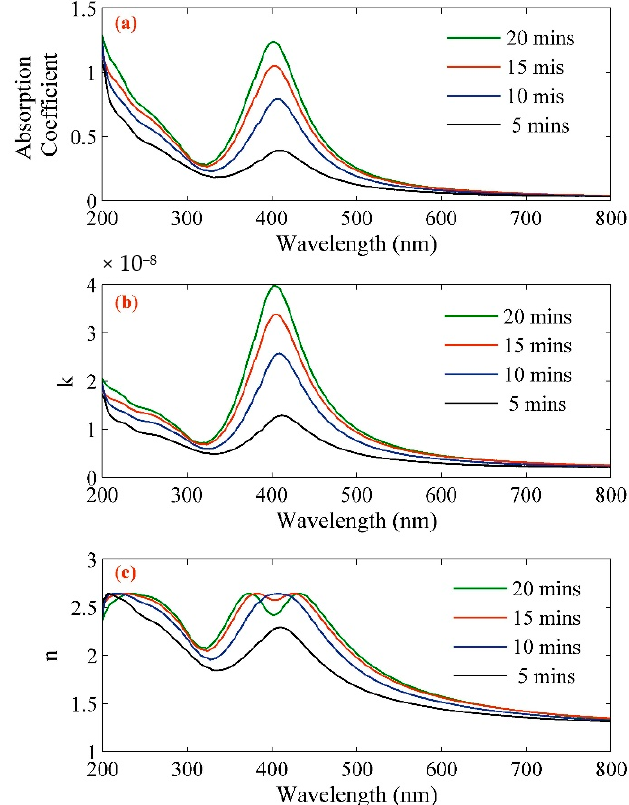
Figure 5. ( a ) Absorption coefficient, ( b ) real part, and ( c ) imaginary part of refractive indices of Ag– NPs/CD composite solution in different ablation time.